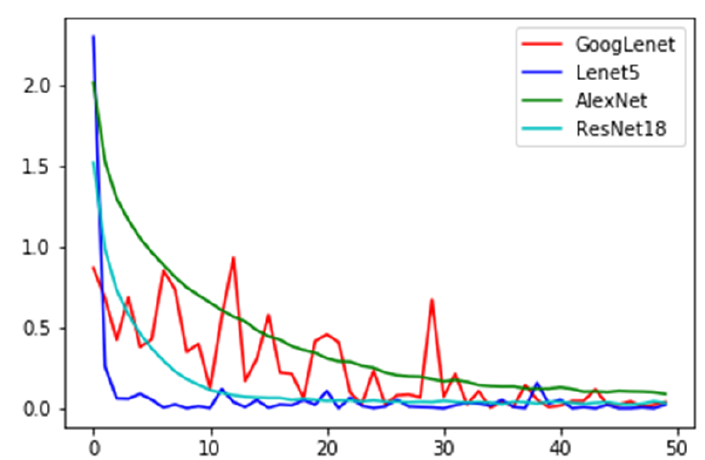
Figure 6. Network training loss.